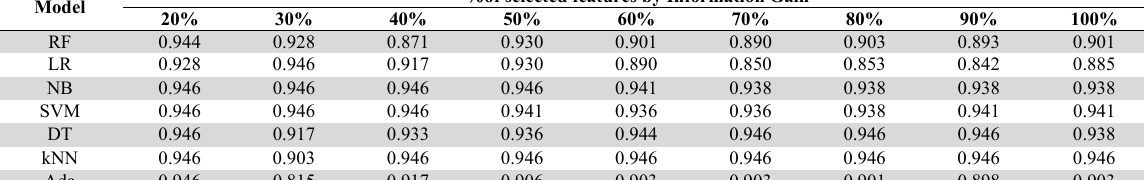
Results of Precision evaluation measure against different feature sets Model